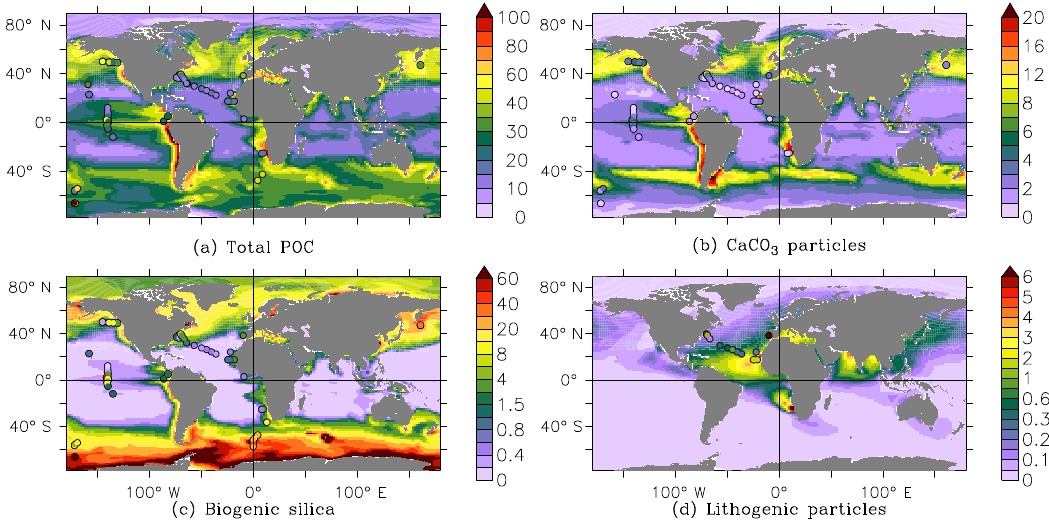
Figure 4. Particle concentrations from the PISCES model at the surface ocean. Observations are represented as coloured discs (Brun-Cottan et al., 1991; Druffel et al., 1992; Lam et al., 2011, 2015). The unit of every modelled and measured particle concentration is mgm − 3